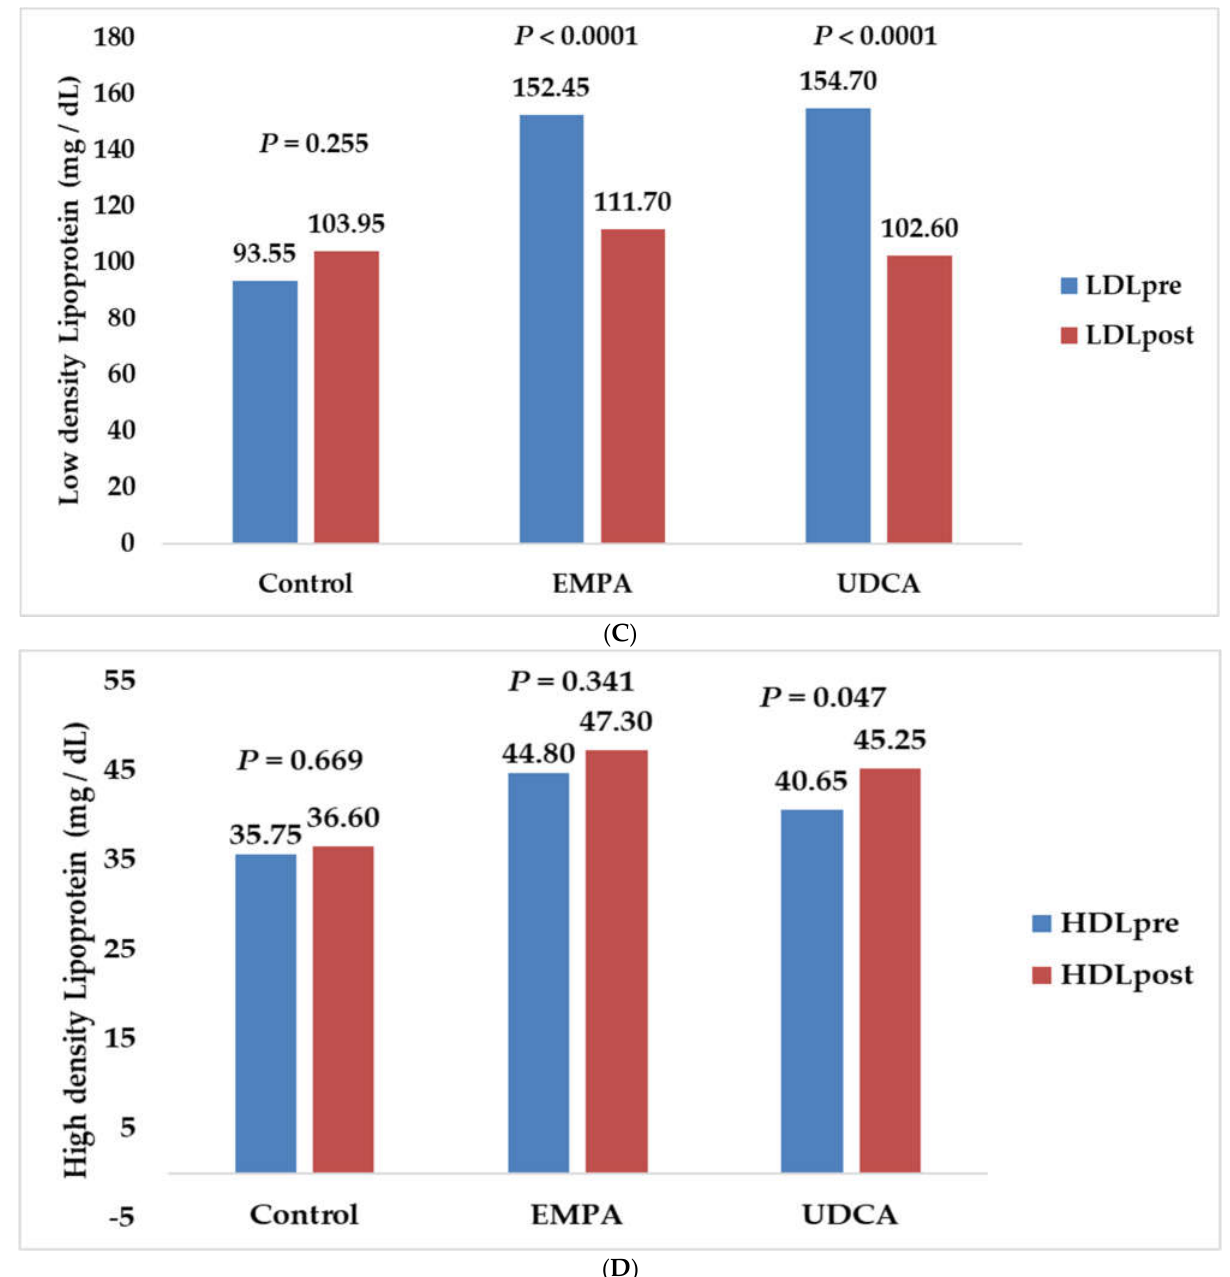
Figure 2. Changes in lipid profiles in study groups after six months. ( A ) Changes in serum triglyc- erides in study groups; ( B ) Changes in total cholesterol in study groups; ( C ) Changes in serum low-density lipoprotein in study groups; ( D ) Changes in high-density lipoprotein in study groups. Moreover, UDCA and EMPA significantly decreased NFS ( − 1.11; p < 0.0001 vs. − 1.00; p < 0.0001, respectively) and FIB-4 index ( − 0.55; p < 0.0001 vs. − 0.34; p = 0.004, respectively) (Figure